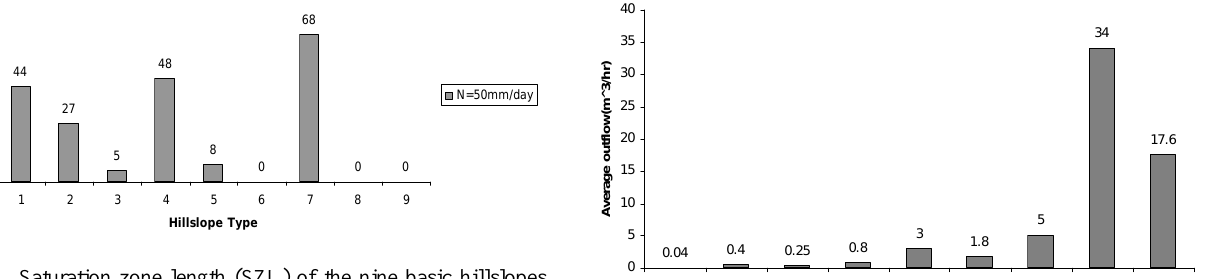
Fig. 9. Saturation zone length (SZL) of the nine basic hillslopes